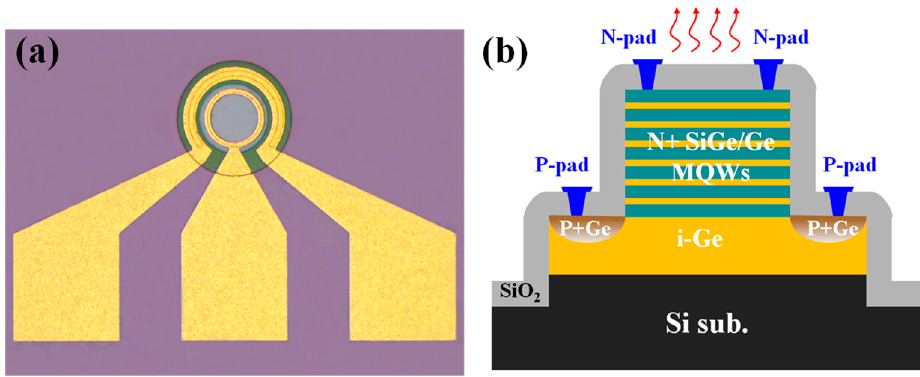
Figure 2. ( a ) Top view image of the fabricated LEDs; ( b ) Corresponding cross section structure.